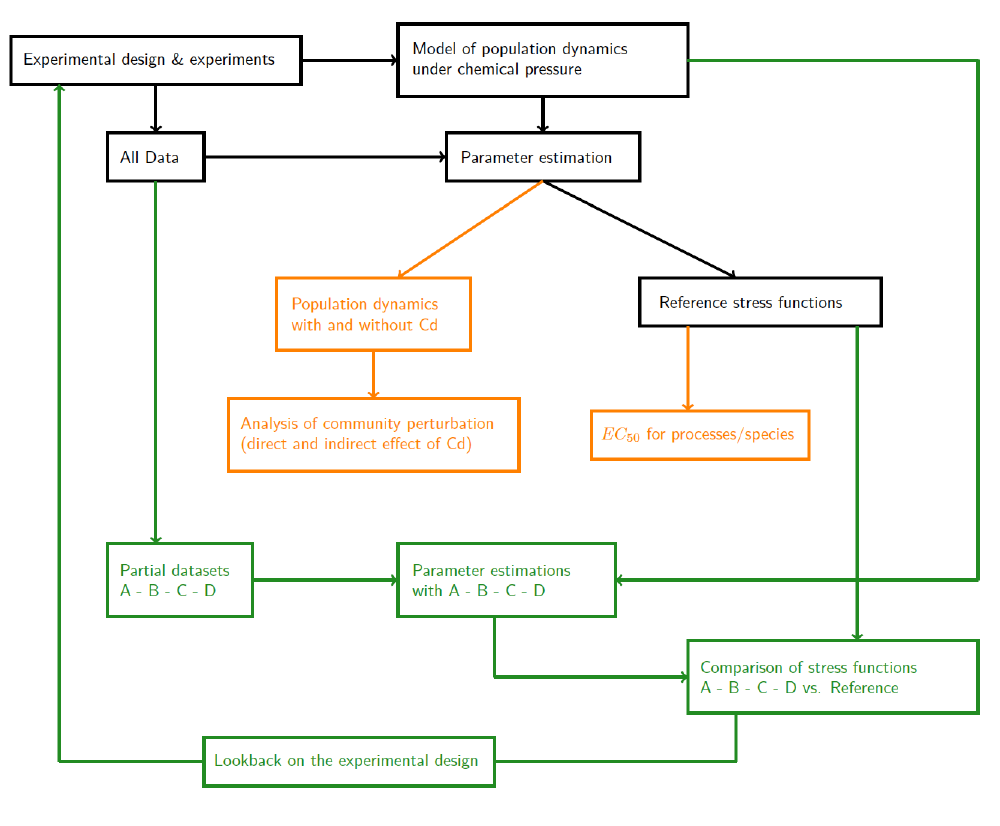
Figure 1. Workflow followed in the present study: (1) in black, development of the model of the microcosm functioning under cadmium pressure, data collection, and estimation of model parameters with the whole dataset, then extraction of stress functions, namely "reference stress functions"; (2) in orange, comparison of population dynamics with and without cadmium to analyse the global perturbation of the community, extraction of EC 50 for the different processes; (3) in green, build of partial datasets by removing some parts of the complete dataset, estimation of parameters using those partial datasets, comparison of the newly estimated stress functions to the reference ones to assess how much information was provided by the removed